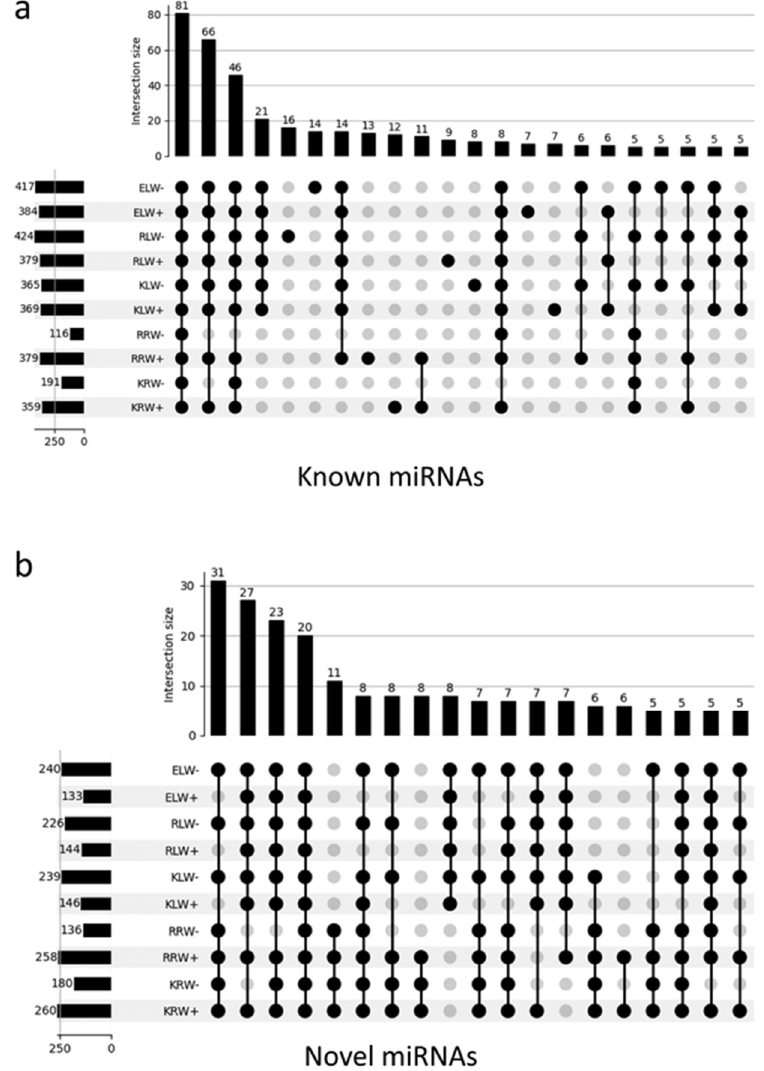
Figure 3. Landscape UpSet plots of all detected known miRNAs ( a ) and novel miRNAs ( b ) in the 10 samples.